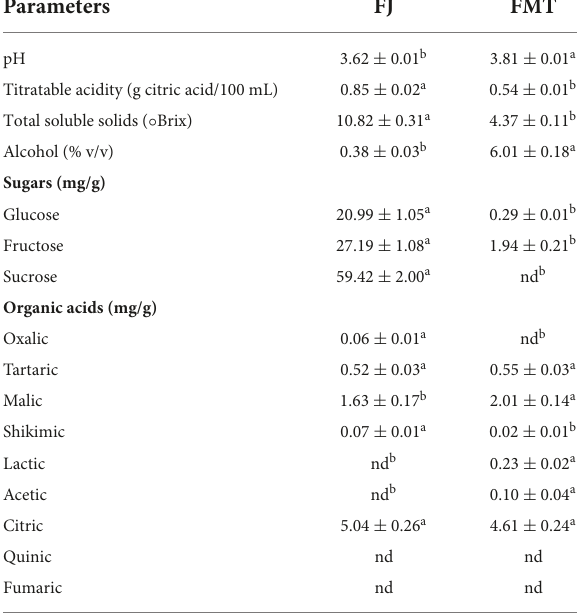
TABLE 1 Quality parameters of grapefruit juice (FJ) and grapefruit fermented juice